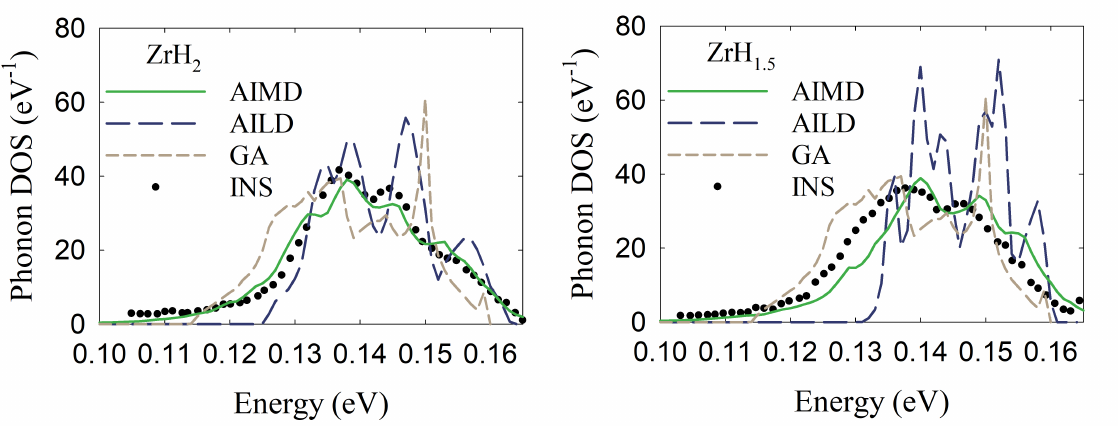
Figure 2. Phonon DOS for hydrogen in (cid:101) -ZrH 2 ( left ) and δ -ZrH 1.5 ( right ) compared to INS [5]. The experimental, AILD, and AIMD phonon spectra differ between phases. The AIMD spectra is used for subsequent evaluation of the hydrogen TSLs in this work.